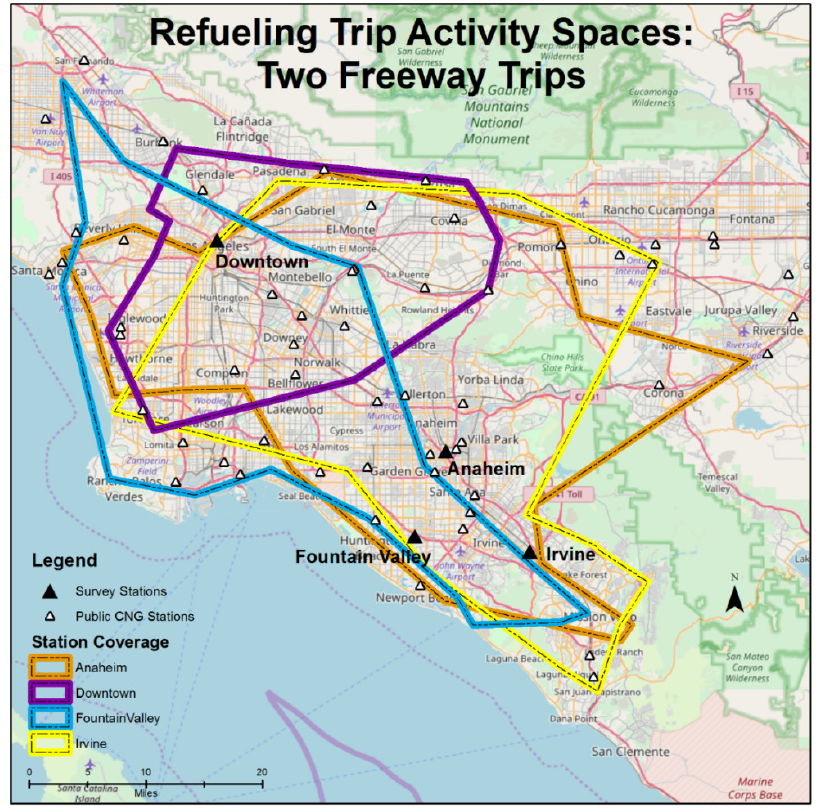
Figure 4. Minimum bounding polygons for all reported previous and next stops relative to the refueling station, by survey site.